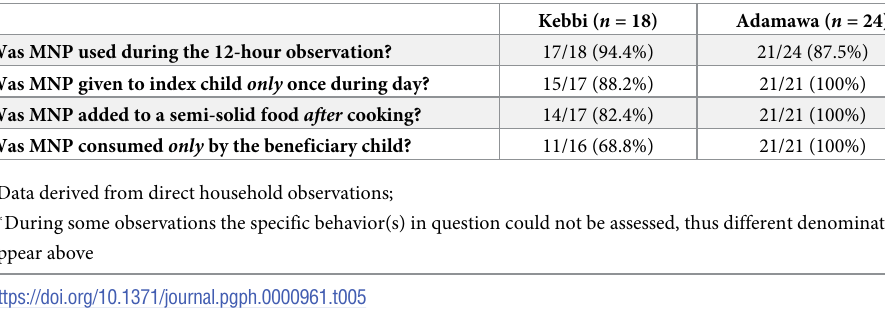
Table 5. Household MNP adherence in Kebbi and Adamawa among children 6–23